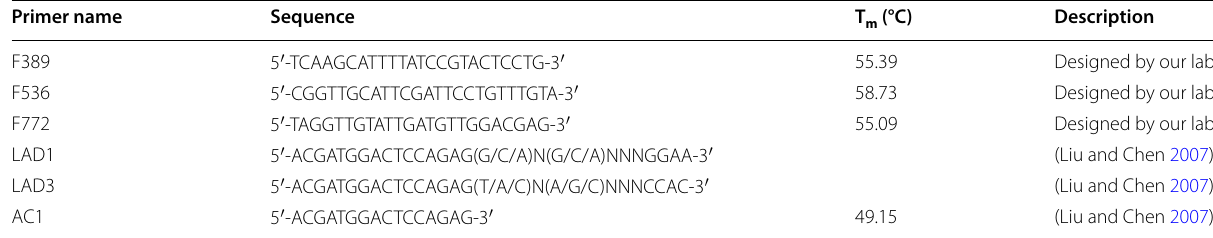
Table 1 Primers used in this